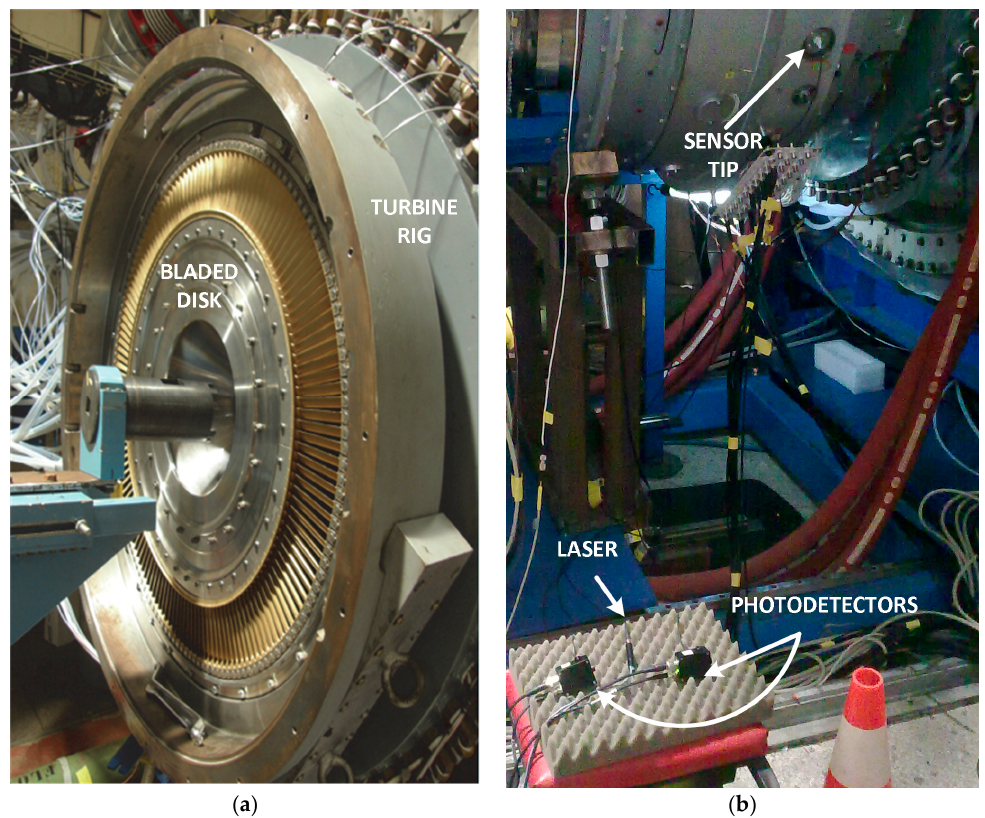
Figure 9. ( a ) Compressor disk with 146 blades in the turbine rig; ( b ) sensor test at the Aeronautical Technology Center (CTA). Technology Center